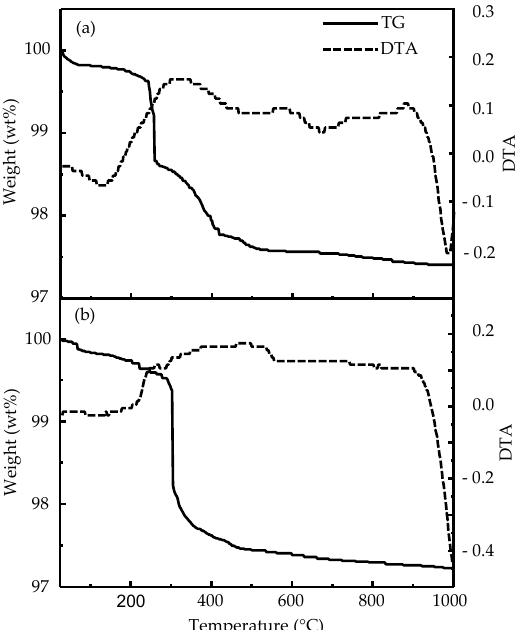
Figure 1. The TG and DTA curves of nano- ( a ) and micro-copper clays ( b ) fired at different temper- atures.